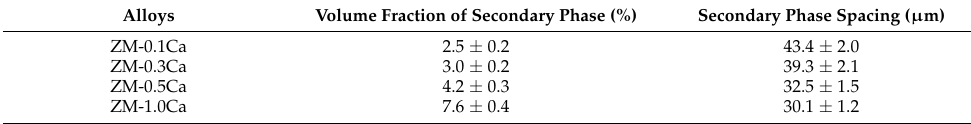
Table 2. Microstructure characteristics of the ZM-xCa alloys (wt.%).